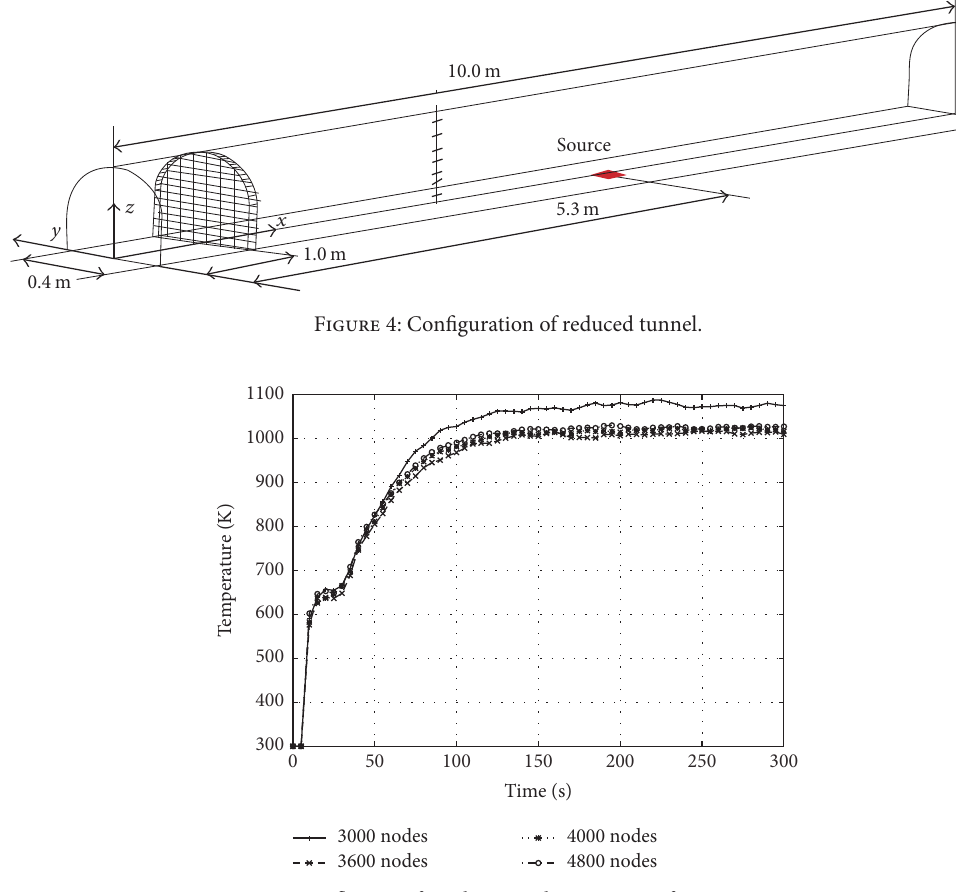
Figure 5: Influence of meshing on the variation of